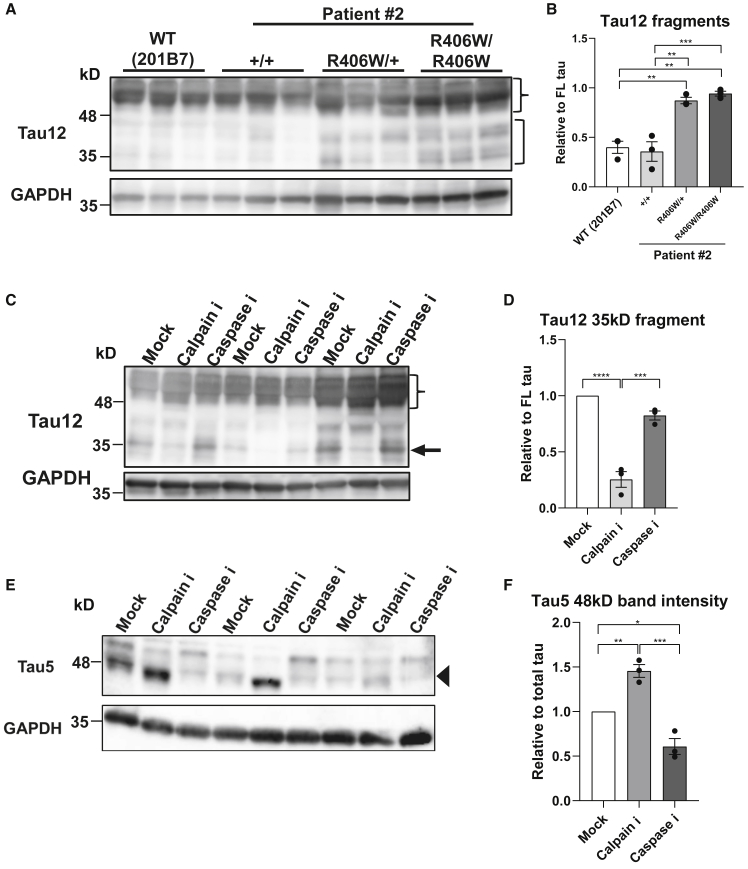
Increased Cleavage of Tau by Calpain Is Dependent on the Phosphorylation State(A and B) Western blot analysis with pan-tau antibody Tau12 (A) revealed increased tau fragments ranging from 35 to 45 kDa (bracket) relative to full-length (FL) tau (brace) in the R406W mutant samples (B) (n = 3 independent experiments).(C and D) Western blot analysis of MAPTR406W/R406W samples with Tau12 when treated with 120 μM Z-VAD-FMK (pan-caspase inhibitor), 250 μM ALLN (pan-calpain inhibitor), or DMSO (mock) (C) revealed a decreased ratio of 35-kDa tau fragments (arrow) to full-length (FL) tau (brace) with calpain inhibition (D) (n = 3 independent experiments).(E and F) Western blot analysis of MAPTR406W/R406W samples with Tau5 when treated with 120 μM Z-VAD-FMK (pan-caspase inhibitor), 250 μM ALLN (pan-calpain inhibitor), or DMSO (mock) (E) revealed an increased ratio of hypophosphorylated tau (48 kDa; arrowhead) to total tau (both 48-kDa and 55-kDa bands) with calpain inhibition (F) (n = 3 independent experiments).Error bars indicate mean ± SEM. One-way ANOVA followed by Tukey's test was performed. ∗p < 0.05, ∗∗p < 0.01, ∗∗∗p < 0.001, ∗∗∗∗p < 0.0001. See also Figure S4.